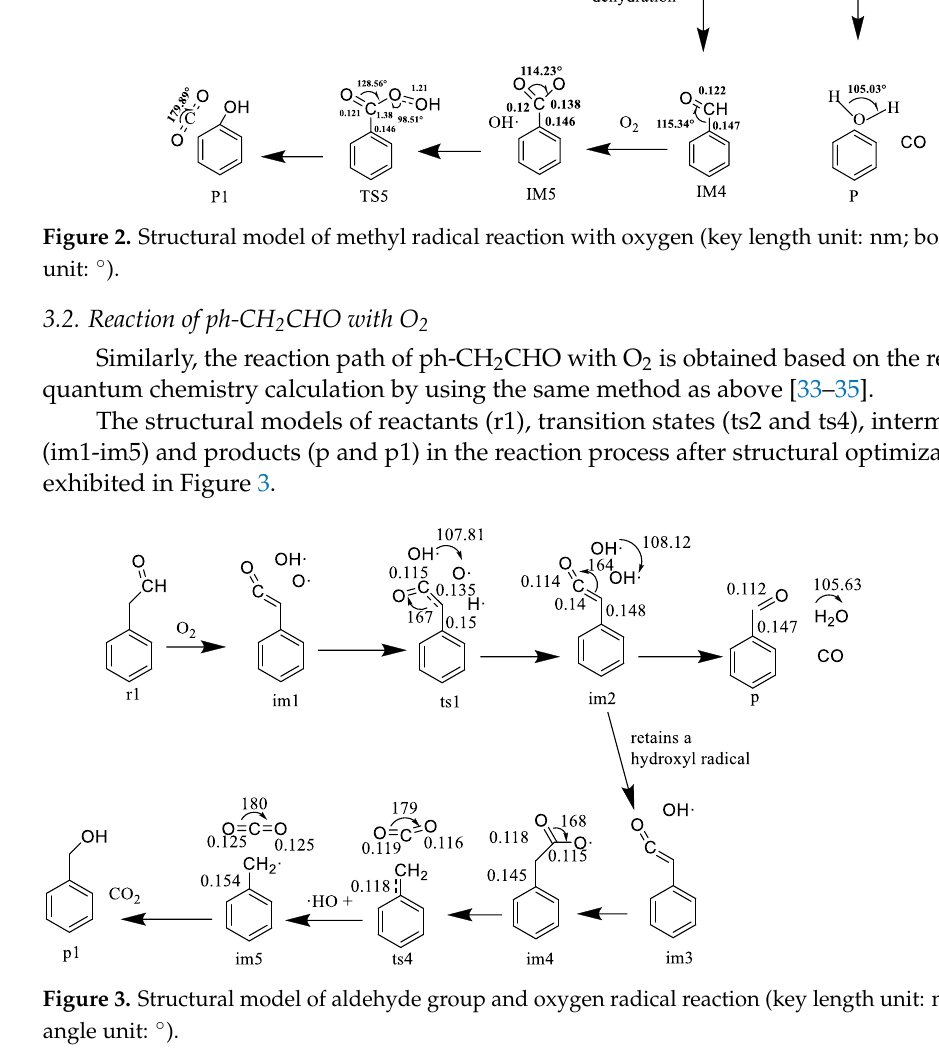
Figure 1. Sample collection and FTIR test process.